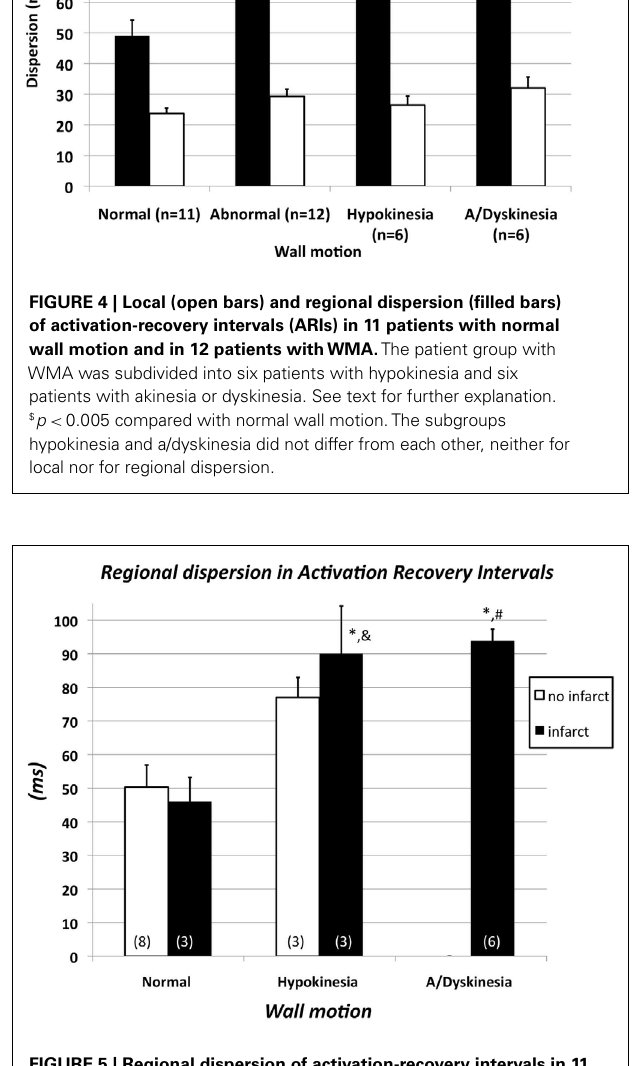
FIGURE 5 | Regional dispersion of activation-recovery intervals in 11 patients with normal wall motion subdivided over subgroups with ( n = 3) and without myocardial infarction ( n = 8), in six patients with hypokinesia subdivided over subgroups with ( n = 3) and without myocardial infarction ( n = 3) and in six patients with akinesia or dyskinesia (see also Figure 3). In the latter group all patients had a history of myocardial infarction.The differences between the five groups are significant (ANOVA; p < 0.0005). Subsequently pairwise comparisons were made. * p < 0.01 vs. normal wall motion/no infarct; & p < 0.05 vs. normal wall motion/infarct; # p < 0.01 vs. normal wall